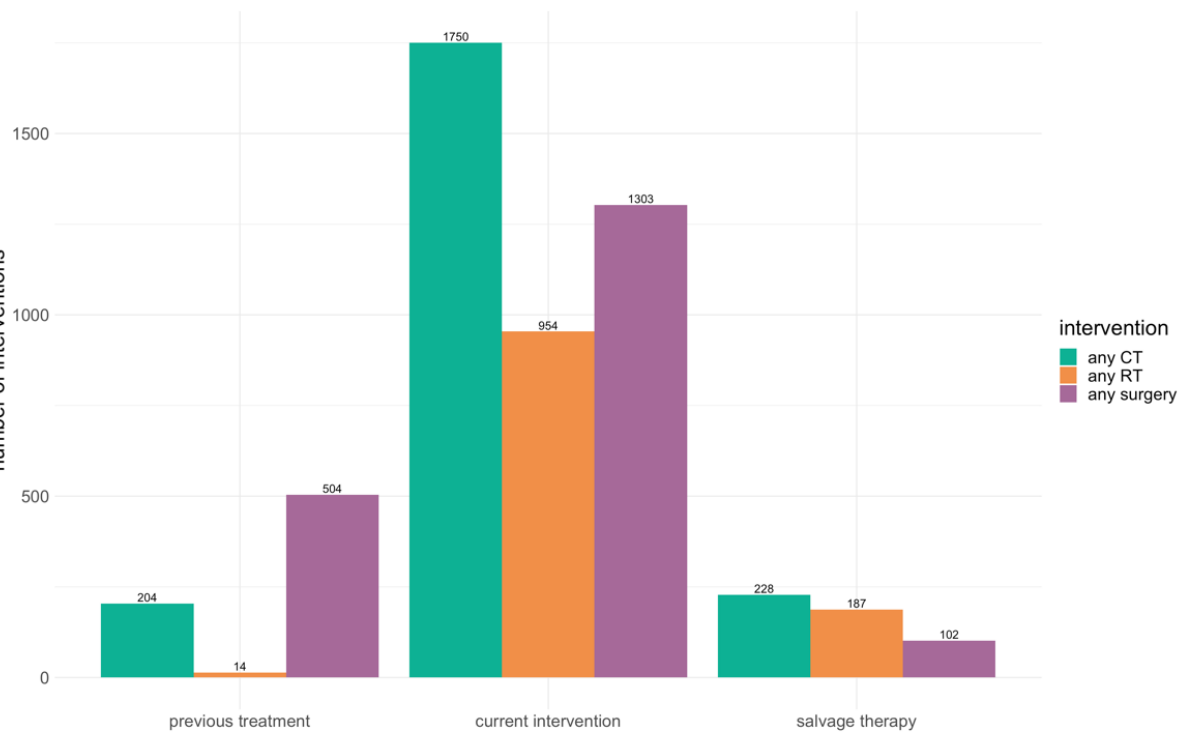
Figure 2. The treatment modalities used for OPG, according to the records of the patients.